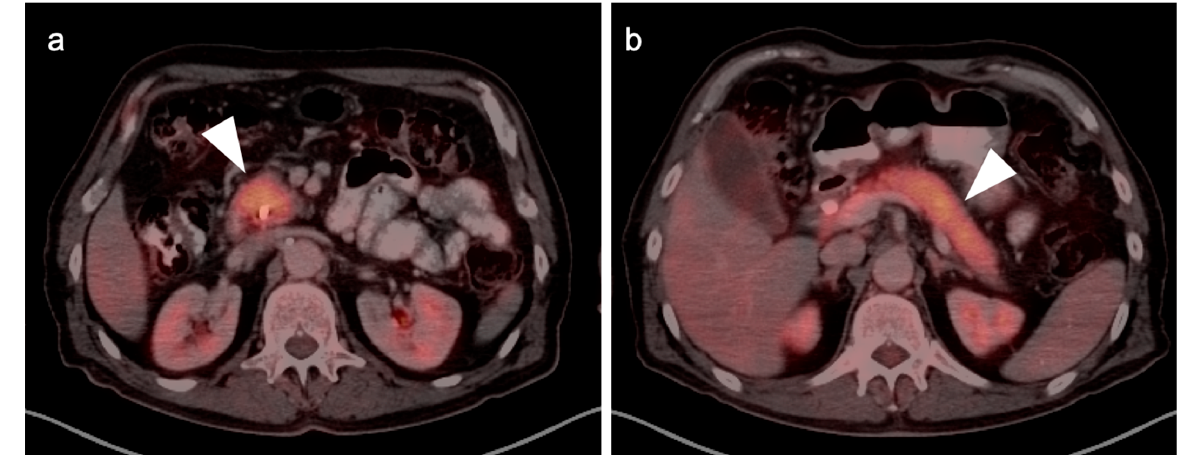
trast-enhanced CT ( a ) and yet highly metabolically active on axial fused FDG PET-CT ( b ) (white